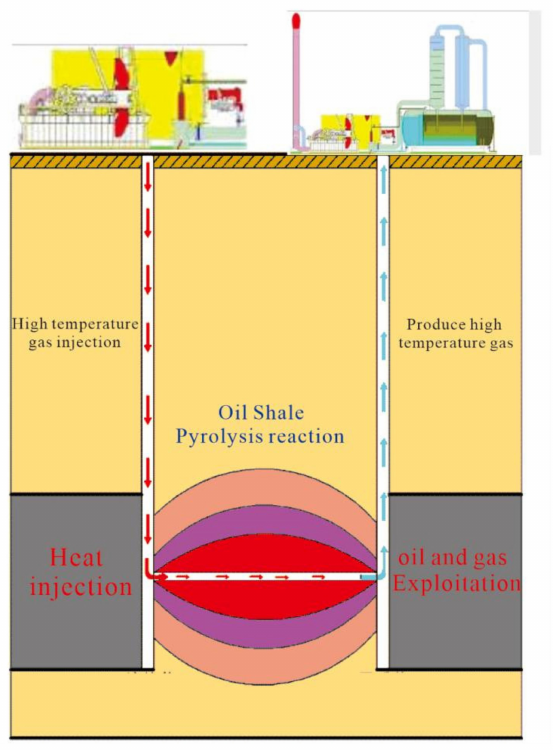
Figure 4. Scheme for the Nongan oil shale in situ conversion